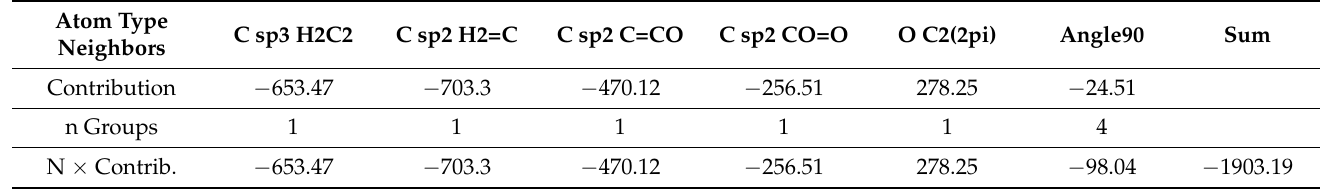
Table 3. Example Calculation of the Standard Heat of Combustion (in kJ/mol) of 4-Methylene-2-oxetanone. Atom Type